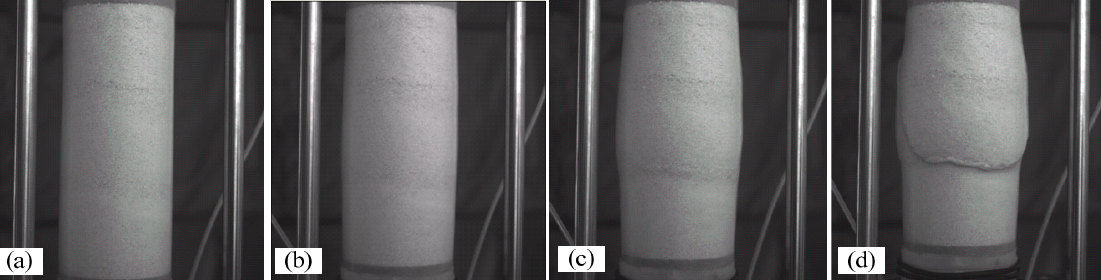
Figure 2. Photo images of deforming specimen 120904c at ( a ) 0.2% ( b ) 3.6% ( c ) 7% ( d ) 12% of axial strain levels [1].